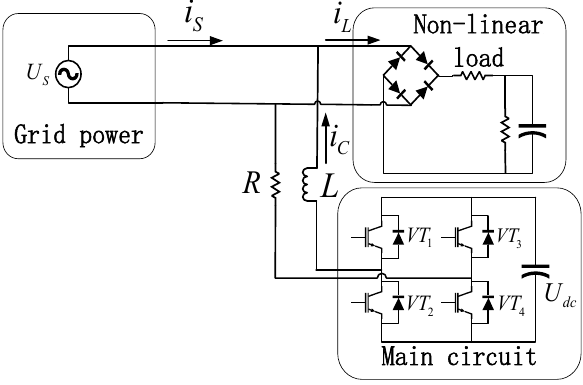
Figure 4. Circuit model of a single-phase APF.